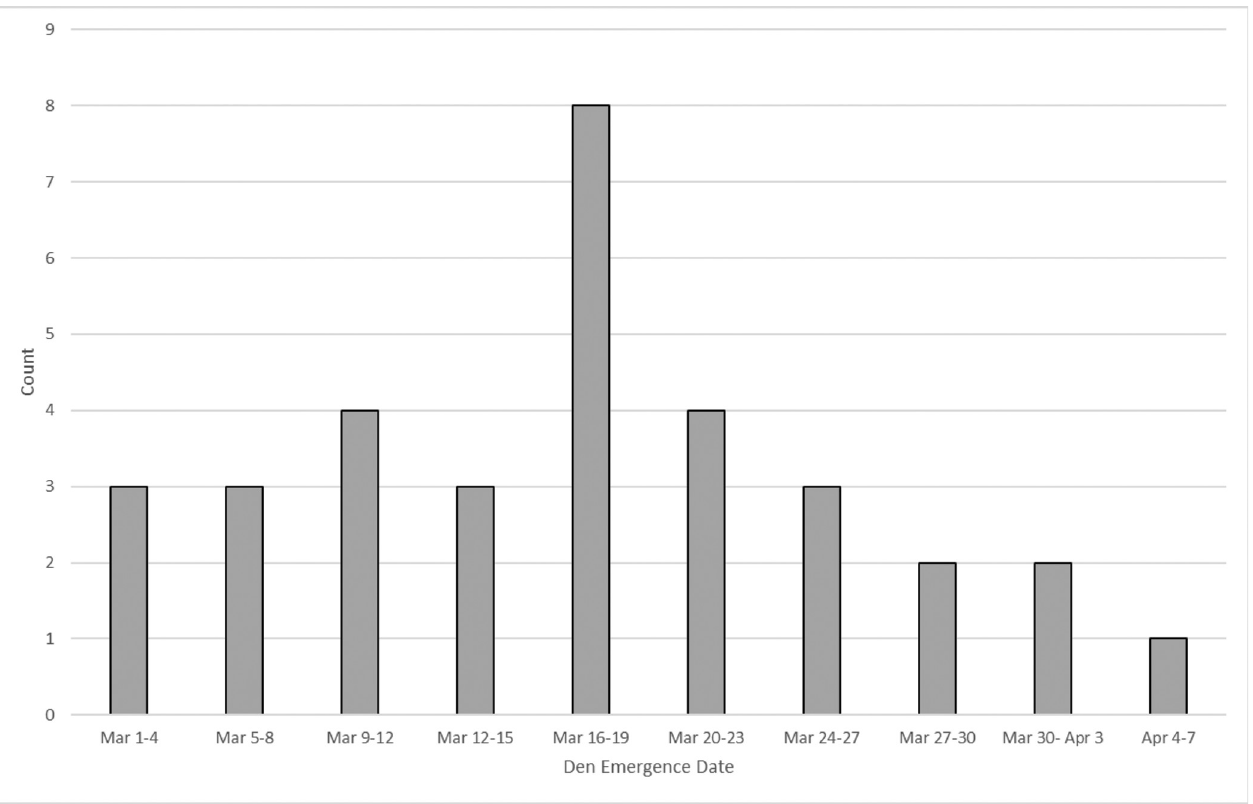
Fig 3. Emergence dates for 32 polar bear dens within the study area from 2002–2014. Emergence time for one den discovered during this study was not accurately known.